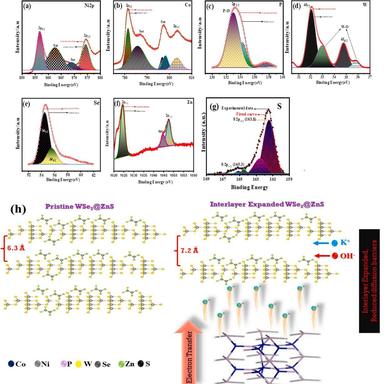
XPS spectra of (a) Ni2p, (b) Co2p, (c) P, (d) W, (e) Se (f) Zn (g) S and the interaction model between the WSe2@ZnS and NiCoP to expand interlayer of WSe2@ZnS.